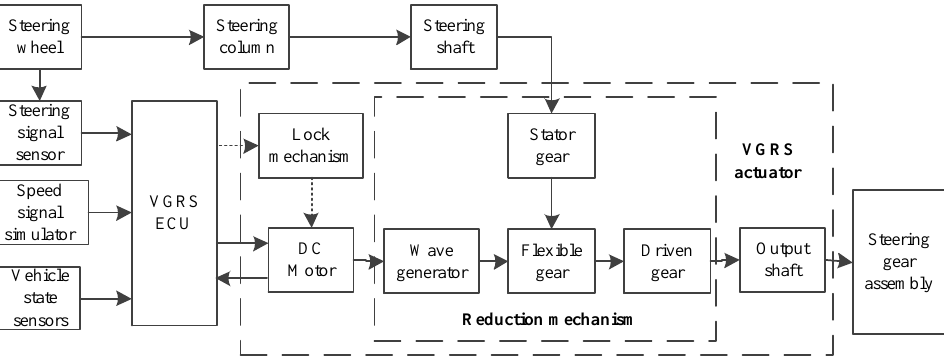
Figure 4. Workflow of AFS system with the VGRS actuator.